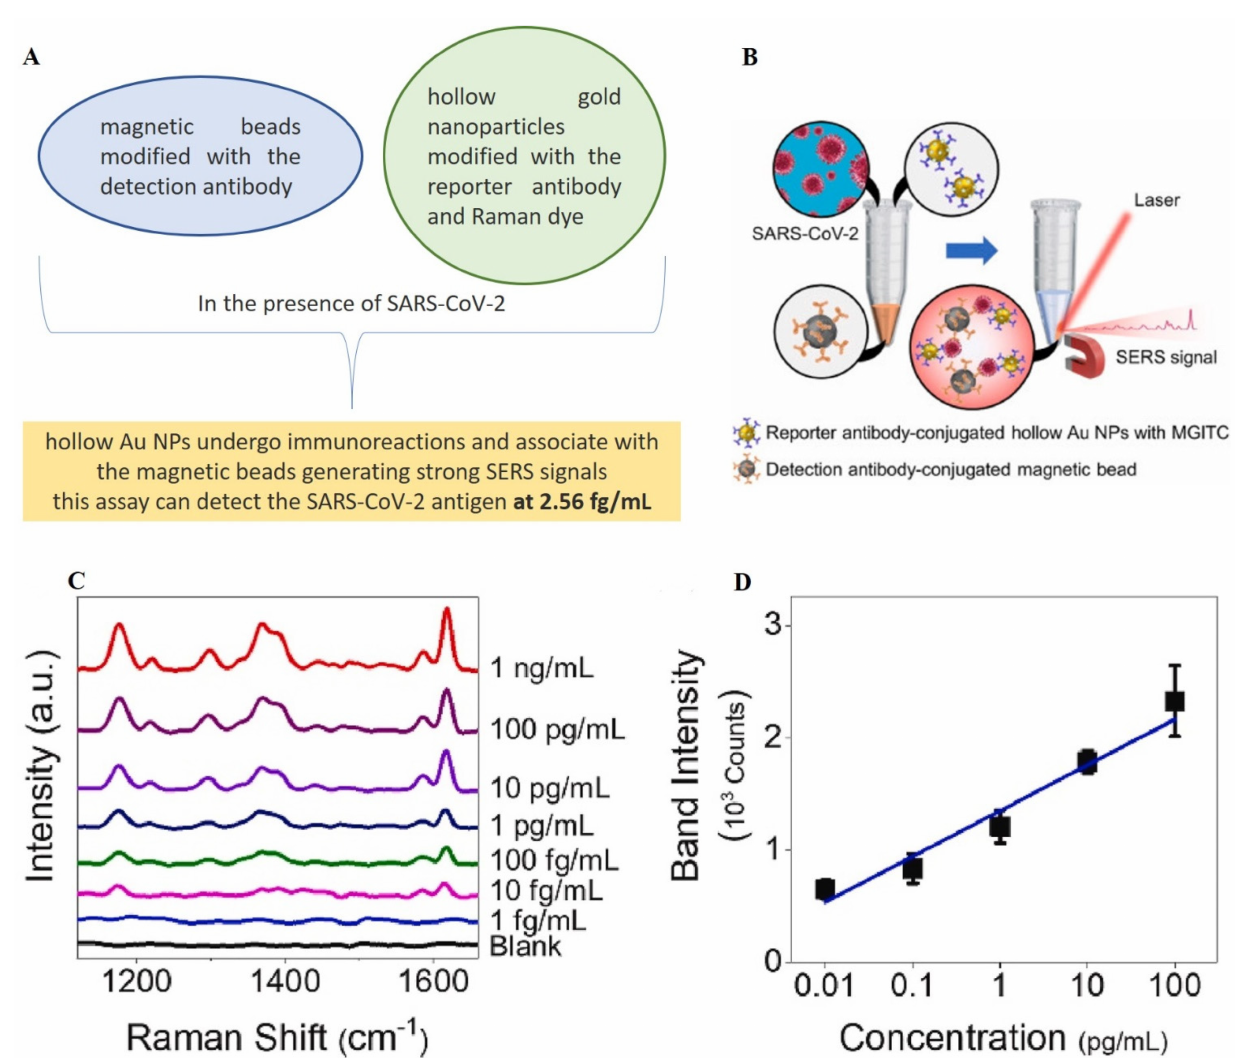
Figure 13. ( A , B ) Flow chart and scheme showing experimental approach for the detection of SARS- CoV-2 using gold hollow nanoparticles and magnetic beads; ( C ) SERS spectra of malachite green measured from the hollow Au nanoparticle-assembled magnetic beads after the detection of the SARS-CoV-2 antigen (0–1 ng/mL); ( D ) a plot of 1170 cm − 1 band intensity as a function of the SARS- CoV-2 antigen concentration. The blue line is linearly fitted. Data represent average ± standard deviation from 10 measurements. Reprinted with permission from [97]. Copyright 2022 Cha et